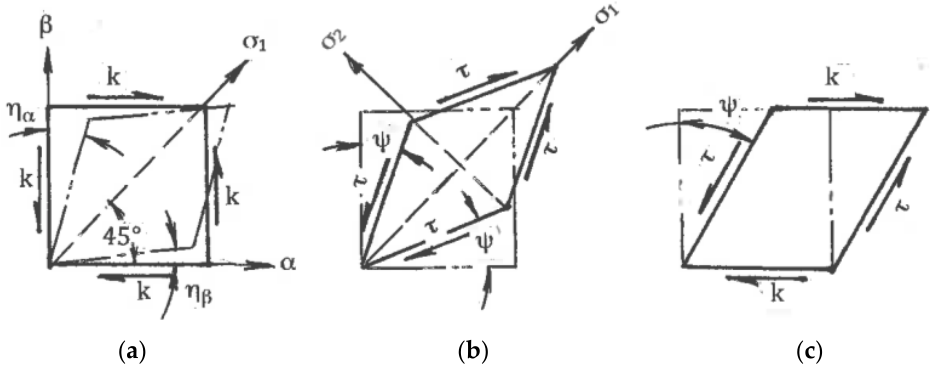
Figure 1. The element distortion along slip lines: ( a ) general case; ( b ) pure shear; ( c ) simple shear. Materials 2018 , 11 , x FOR PEER REVIEW